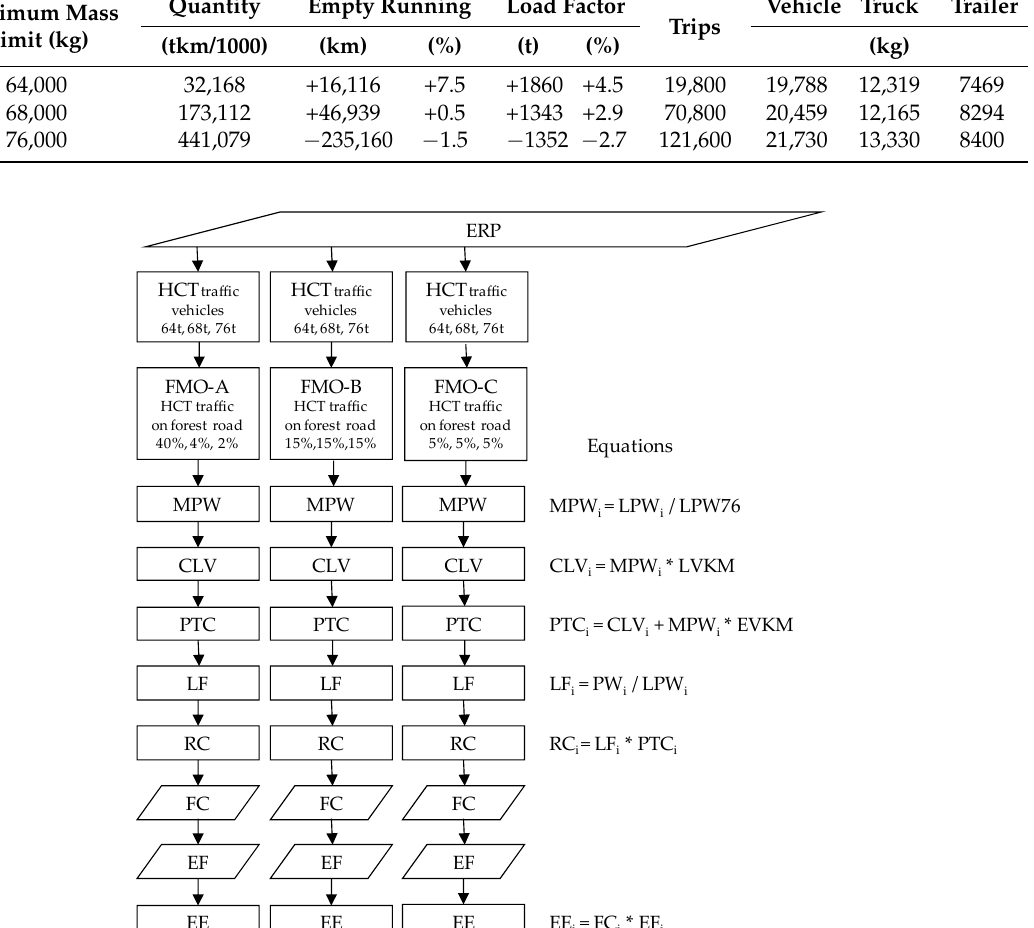
Table 2. Road-freight transportation data in 2016. The maximum mass limit of HCT, average timber quantity, quantitative difference between empty vehicle distance and laden vehicle distance, difference in load factor, number of trips and the average mass of the empty vehicle combinations.